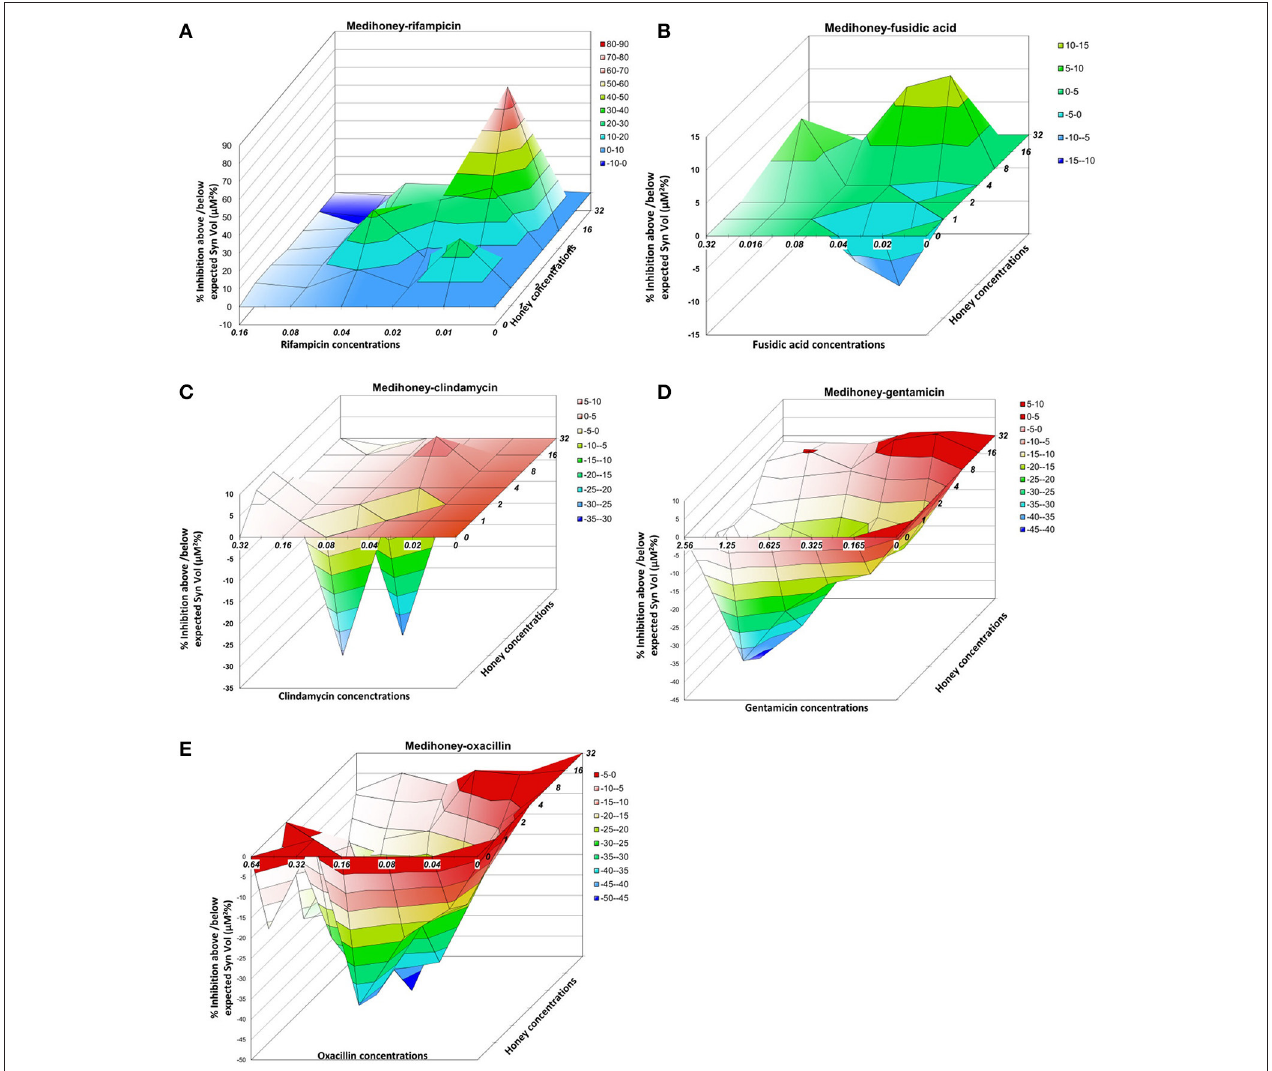
FIGURE 3 | Three-dimensional dose-response plots highlight substantial differences in the effect of Medihoney-antibiotic combinations on established S. aureus biofilms Interaction surfaces were calculated based on response surface analysis using MacSynergy II. Additive interactions appear as a horizontal plane at 0% inhibition. Peaks of statistically significant synergy (positive value) or antagonism (negative value, troughs) that deviate significantly from the theoretical expected additive interaction surface are shown, with different colors indicating the level of synergy or antagonism. Antibiotic concentrations (x-axis) are in µ g/ml and honey (z-axis) in % weight per volume. Plots show combinations of Medihoney with: (A) rifampicin; (B) fusidic acid; (C) clindamycin; (D) gentamicin; and (E) oxacillin.